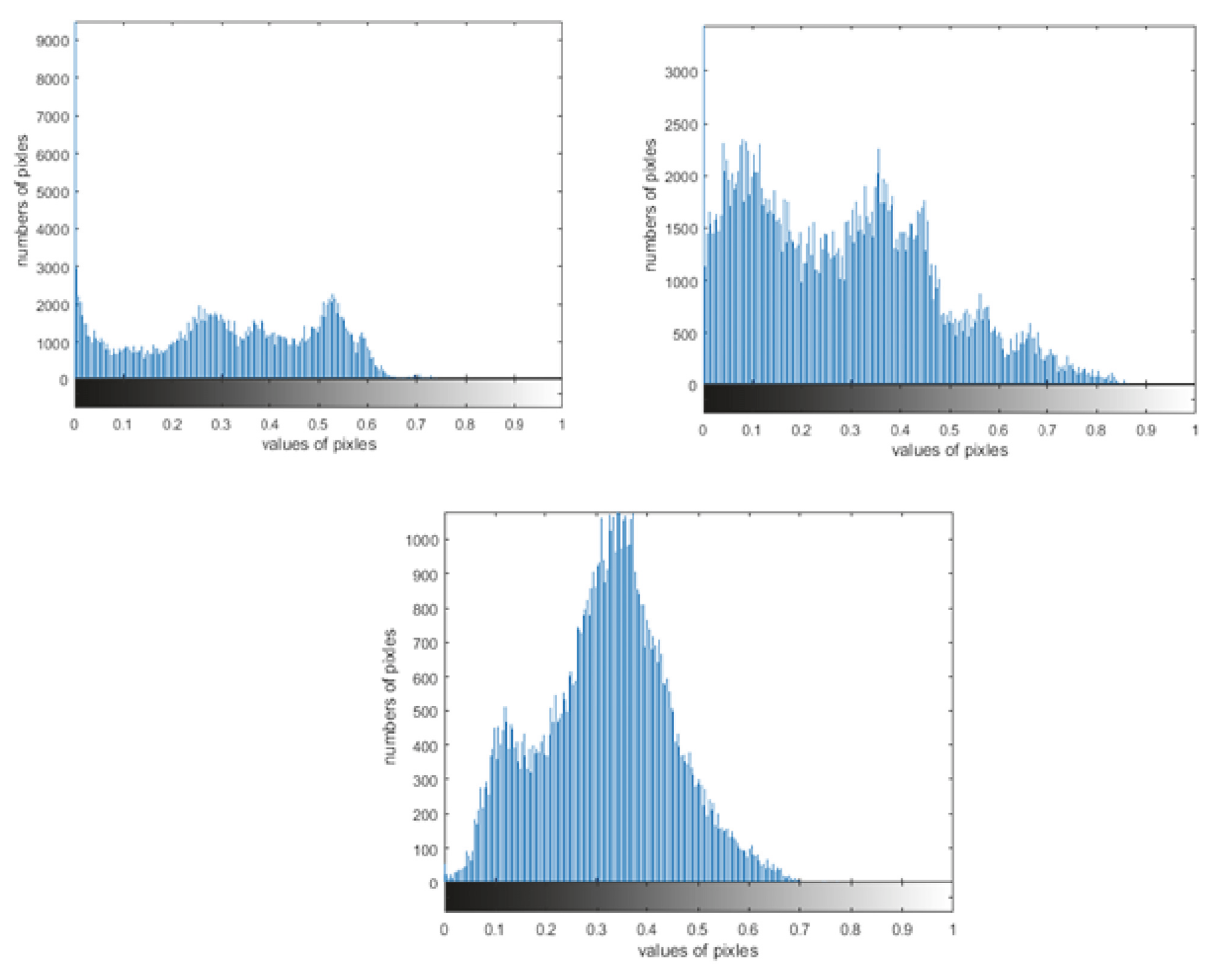
Figure 5: Histogram of dark channel values without obvious light color